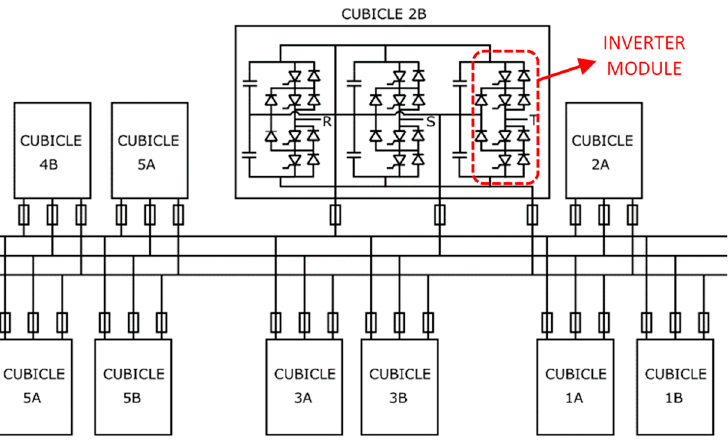
Figure 6. Topologies for the position of the fuses.